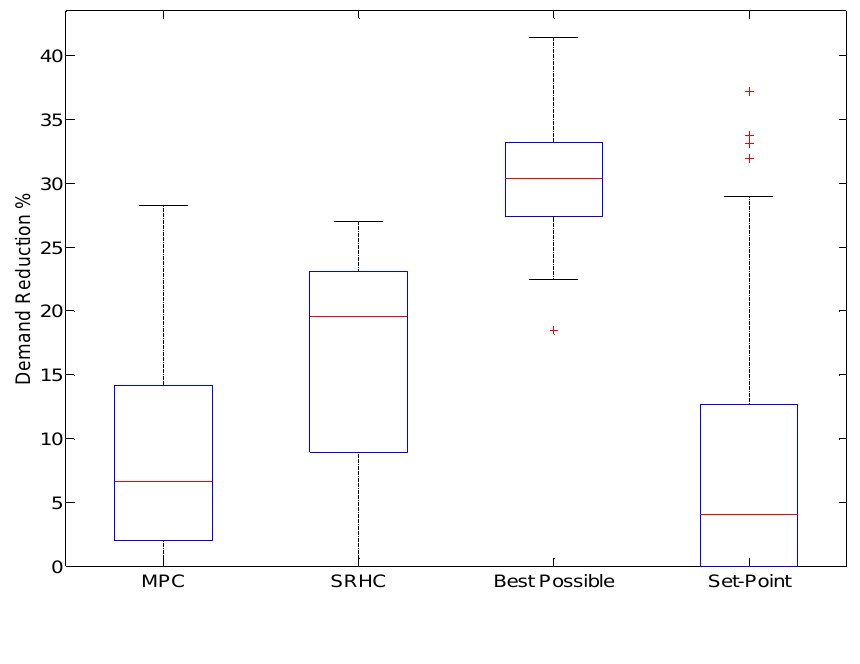
Figure 9. Box plots showing the distribution of demand reduction achieved using algorithms (from left to right) MPC, SRHC, best possible demand reduction and set-point